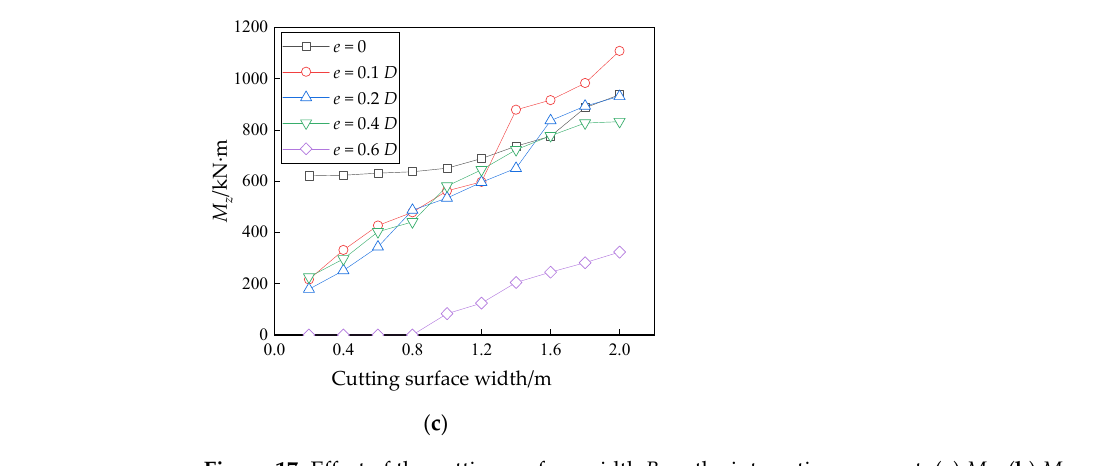
x ; ( b ) M y and ( c ) M z .